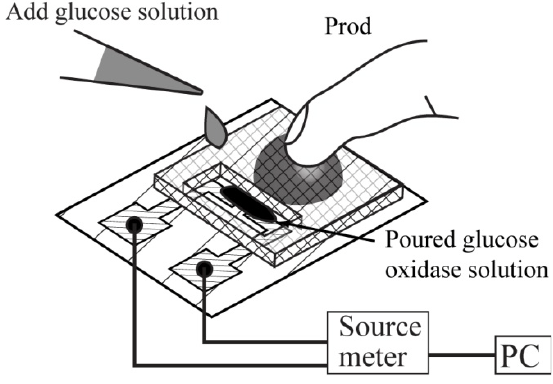
Figure 3. Experimental setup of glucose sensing with a packaged glucose oxidase solution.